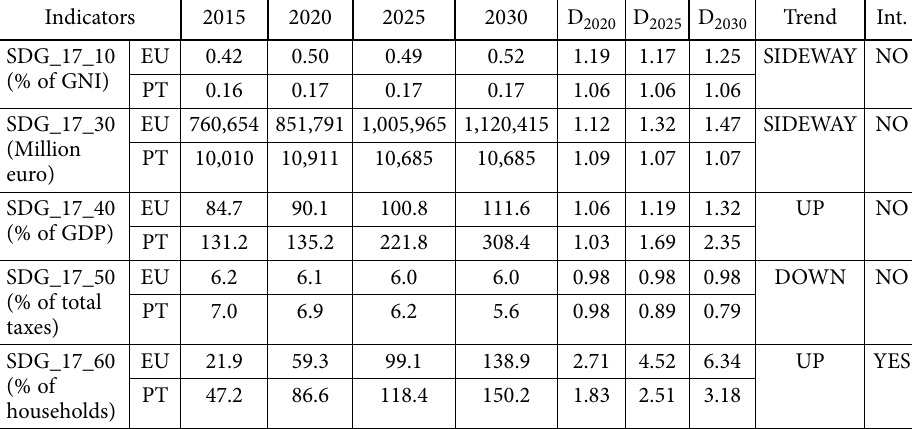
Table 18. SDG 17 – Partnerships for the goals